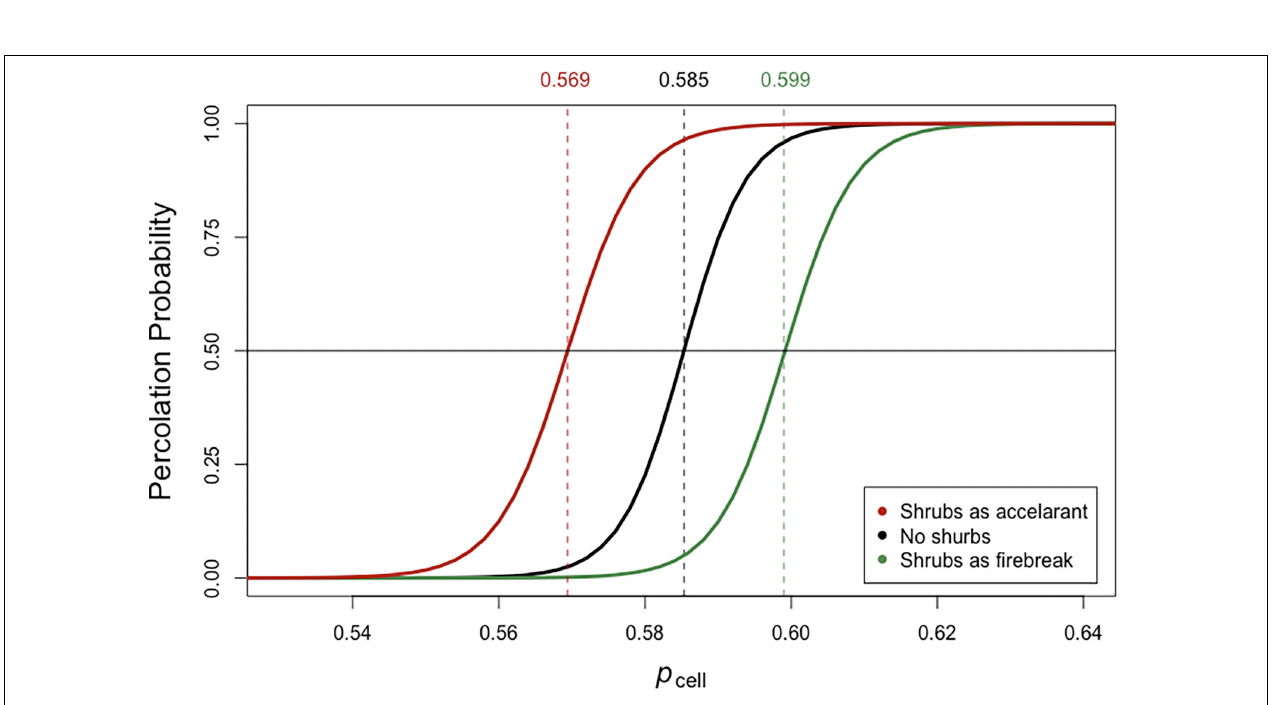
FIGURE 8 | Percolation probabilities for binary landscapes with shrubs acting as firebreaks (shrubs do not burn) or accelerants (shrubs burn) as compared to a landscape with no shrubs. Shrubs were randomly assigned with a distribution and size closely mimicking measured shrubs in the Mojave experiment (see section “Materials and Methods”). Vertical dotted lines are values at which there is a 50:50 probability that fire will percolate across the landscape in the vertical direction.